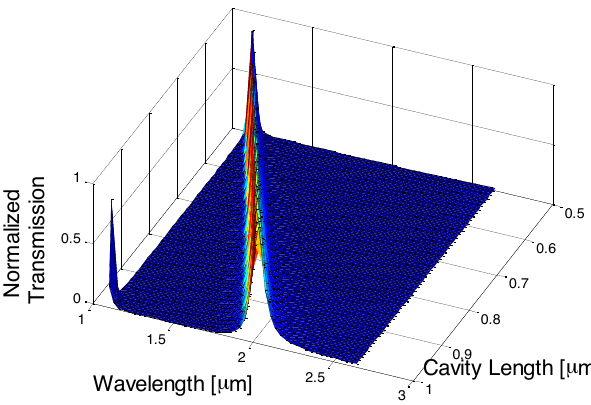
Fig.3. Tuning the length of the resonator controlling the resonance wavelength 2.1.1.2